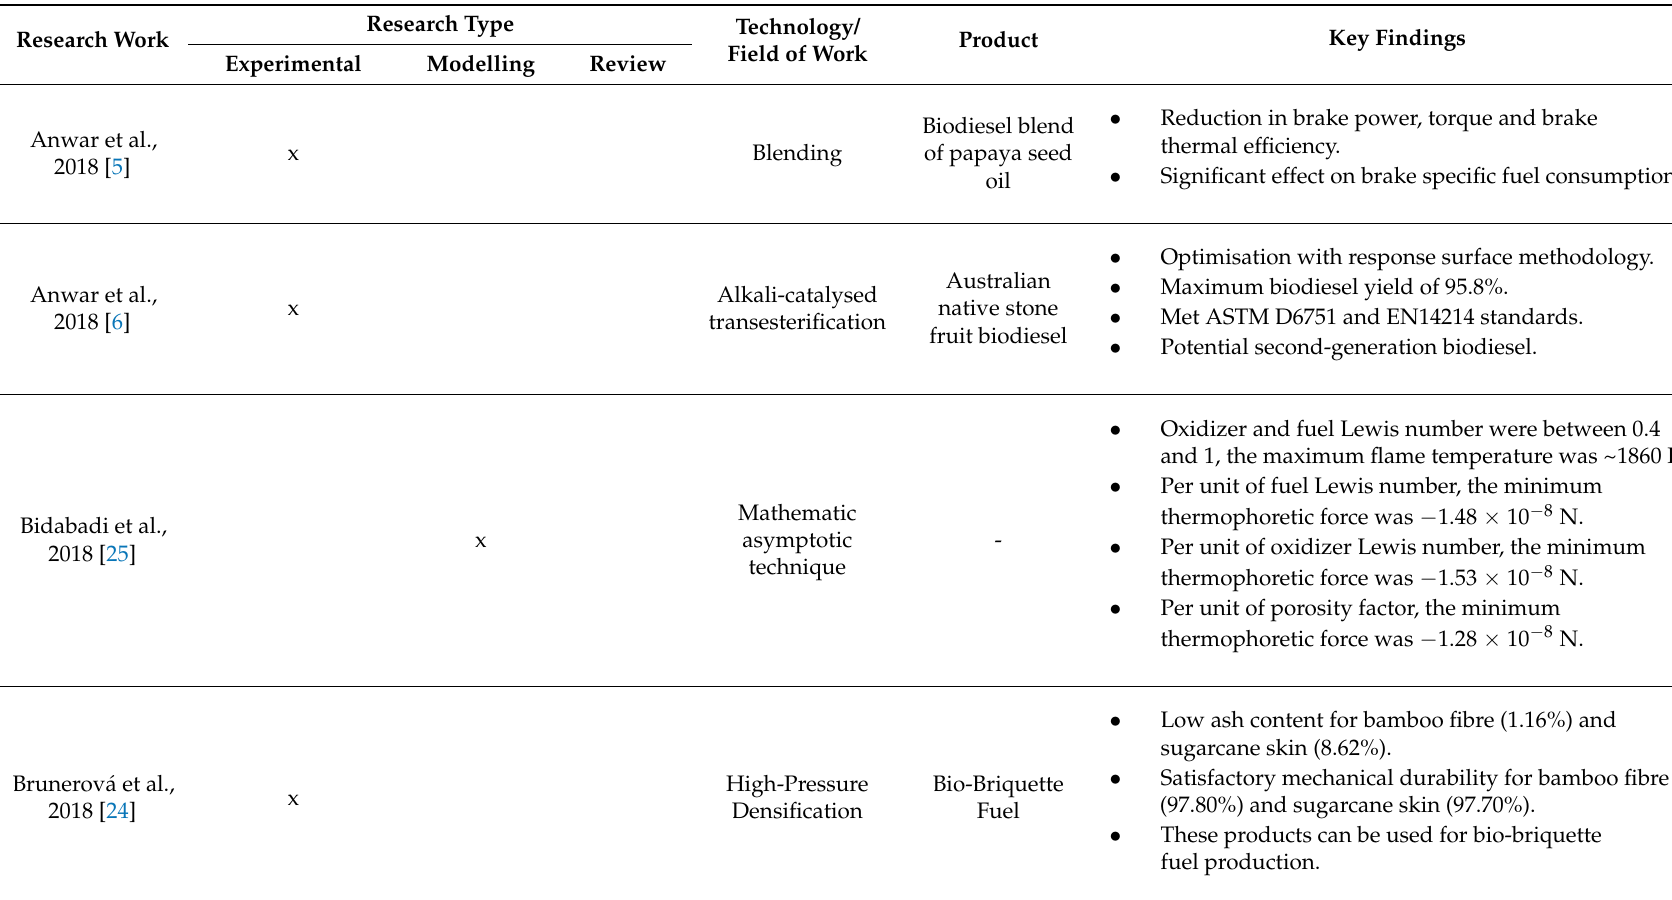
Table 1. Key Information of the Publications Submitted to Special